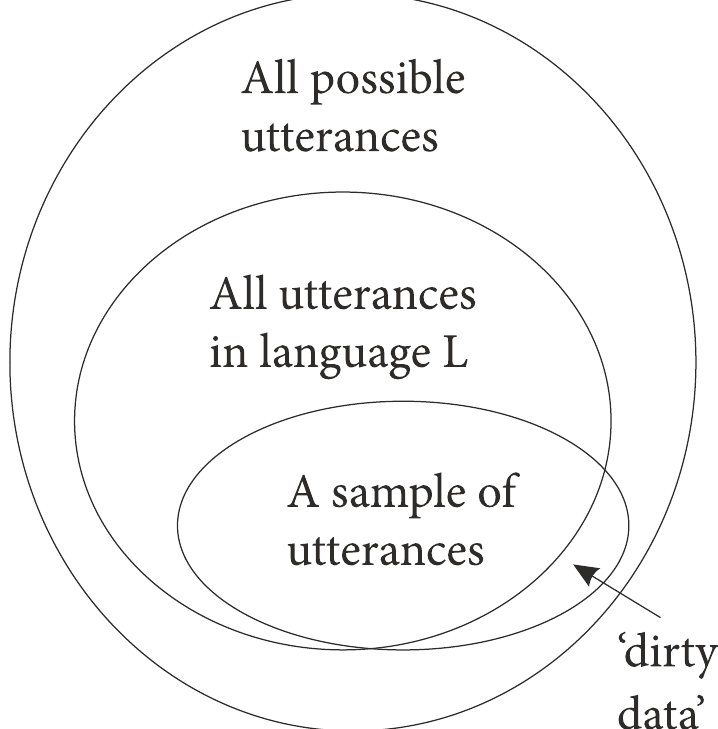
Figure 16: Categories of utterances involved in the learning of a first language, L . In ascending order size, they are the finite sample of utterances from which a child learns, the (infinite) set of utterances in L , and the (infinite) set of all possible utterances. Adapted from Figure 7.1 in [98], with